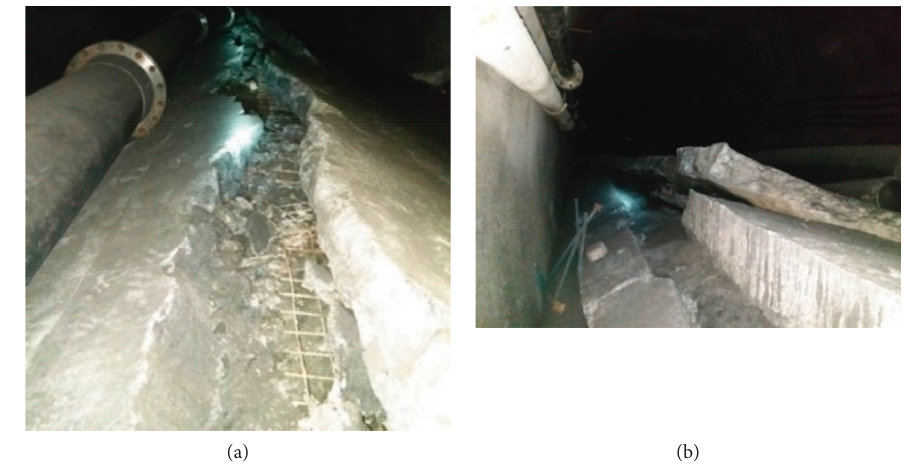
Figure 3: Photos of the main roadway